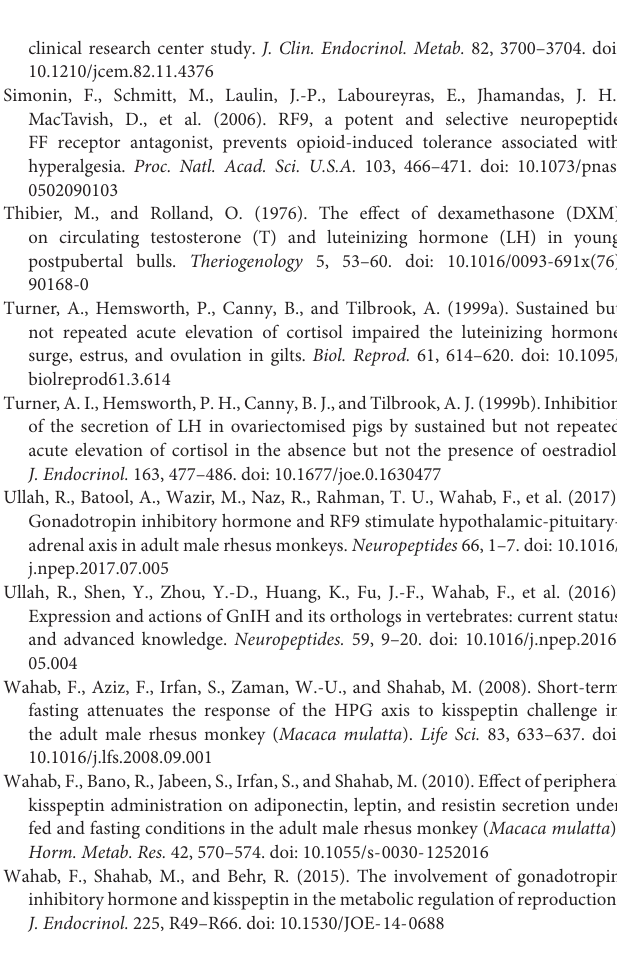
Supplementary Figure 1 | Changes in mean plasma cortisol concentration during 11 day treatment of hydrocortisone in the intact adult male rhesus monkeys ( n = 6). Total daily dose (20 mg/kg BW) was split into three im injections (at 9 am, 3 pm, and 9 pm). One-way ANOVA with post hoc Bonferroni test showed that